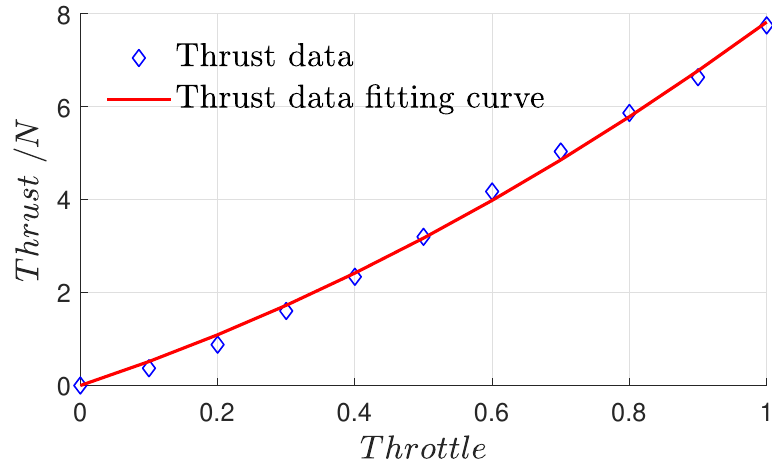
Figure 3. Propeller thrust fitting results.